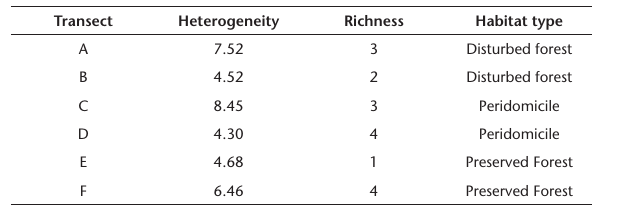
Table 3. Environmental heterogeneity and species richness for each transect for the 2012-2015 period in CFMA, Rio de Janeiro, Brazil.